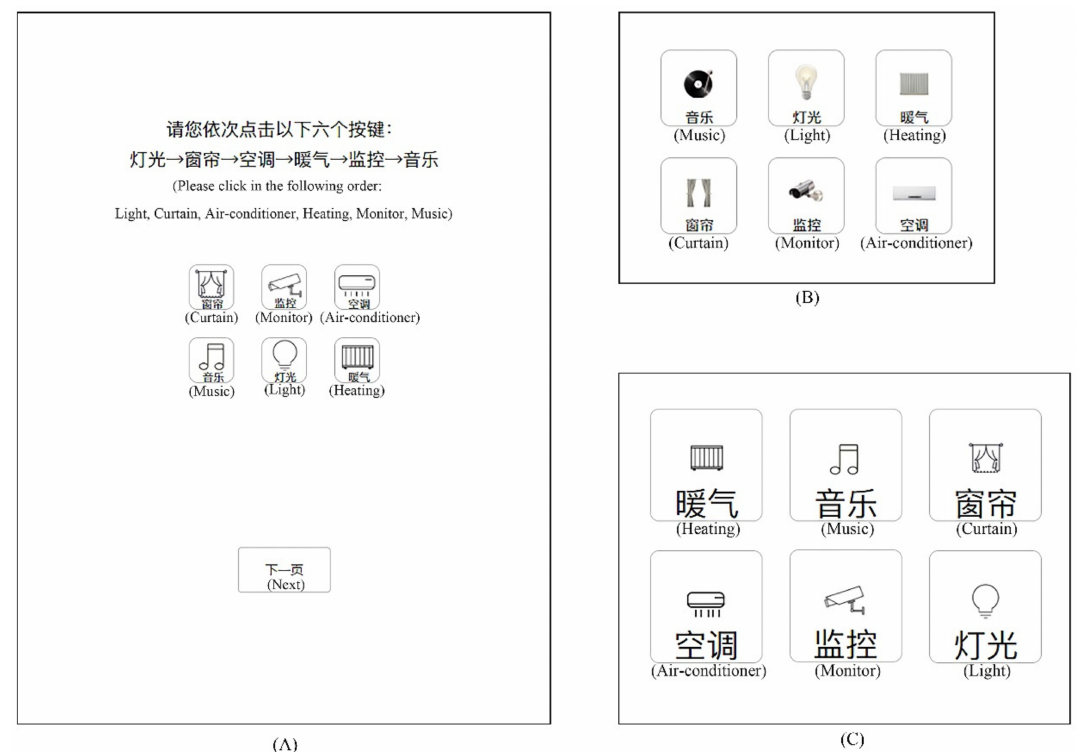
Figure 1. Examples of screenshot for clicking tasks of smart home touchscreen interfaces ( A ), a full page of experimental interface showing buttons with 10 mm size, graphics/text ratio of 3:1, and flat icons. ( B ), part of page showing buttons with 15 mm size, graphics/text ratio of 1:1, and skeuomorphic icons. ( C ), part of page showing buttons with 25 mm size, graphics/text ratio of 1:3, and flat icons. English words in parentheses were not shown during the